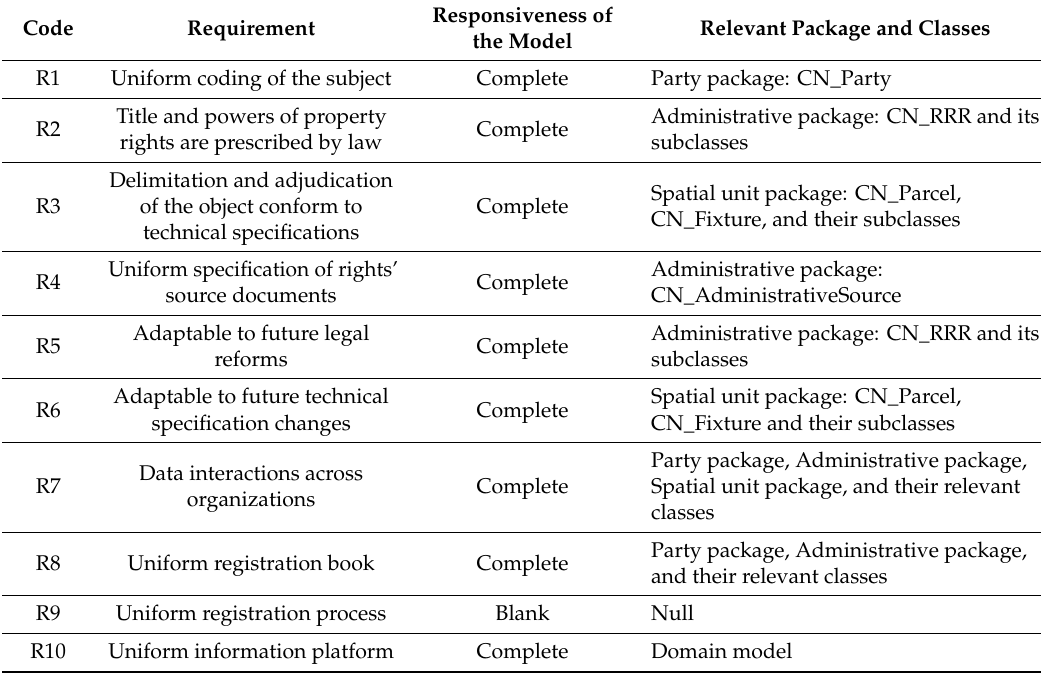
Table 2. Responsiveness of the domain model to user